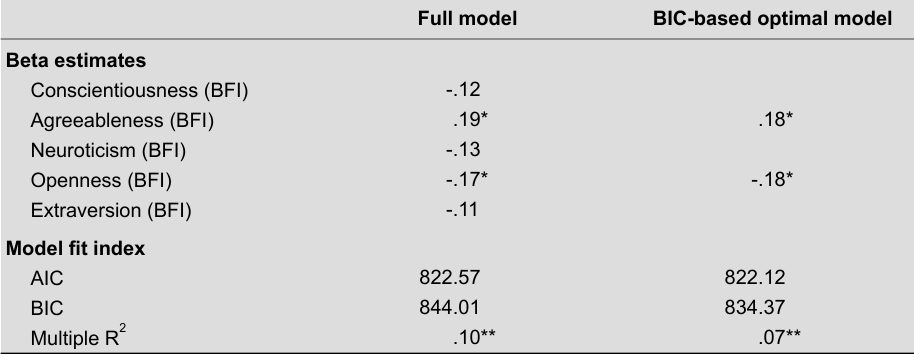
BIC-based optimal modelFull